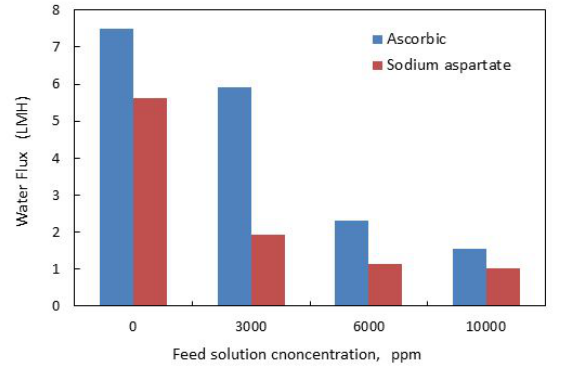
Fig. 5. Average water flux versus different feed solution concentrations (T= 25 0 C, draw solution conc. 1M ascorbic acid, 1M sodium- aspartate, FO mode). Fig. 6. The impact of dilutive ICP on the driving osmotic